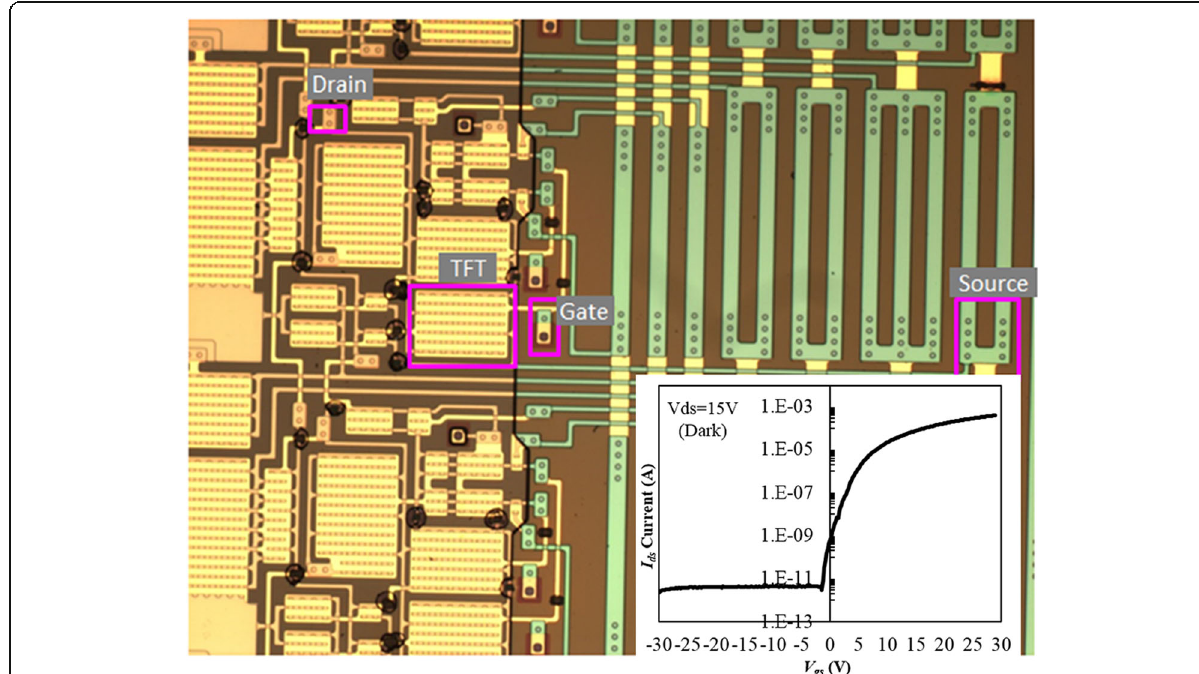
Fig. 2 Photographs of the GOA TFTs electrically separated from the GOA circuits (insert: I off noise current between the TFT of interest and the other peripheral TFTs)